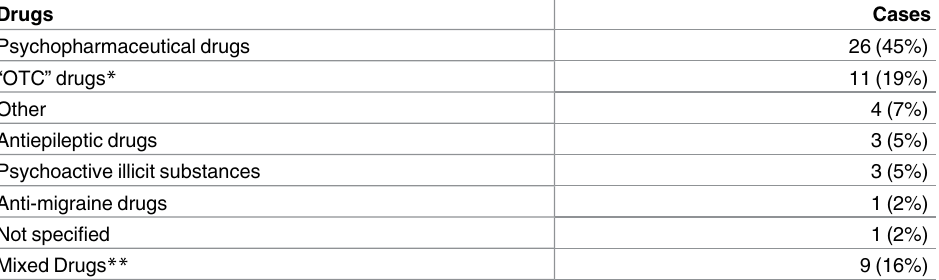
Table 5. Drug poisoning among SITBs cases visited in the EDs: frequency and percentage (%) of cases for each drug used (n = 58). Drugs